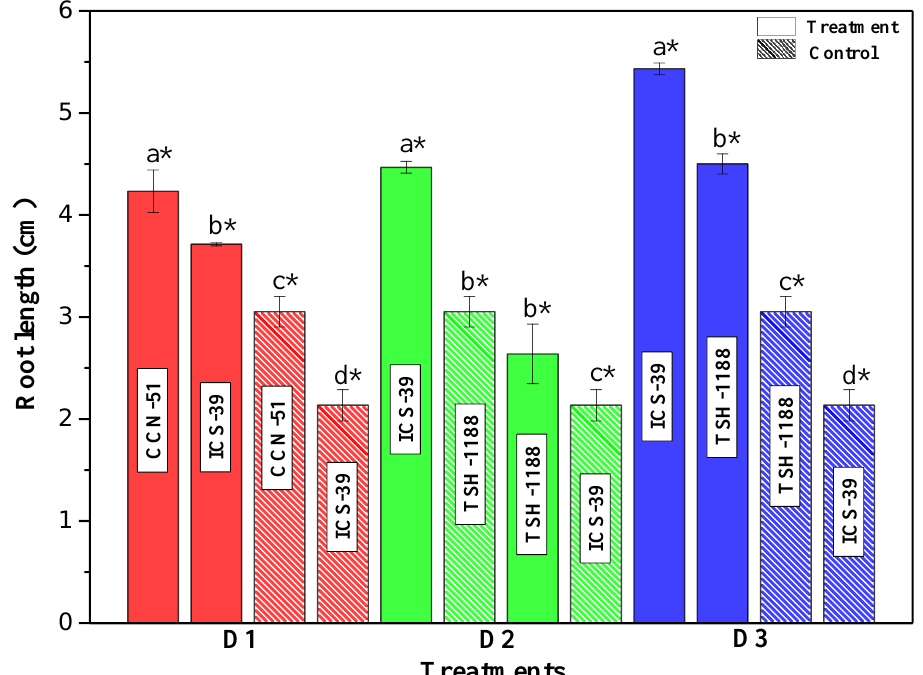
Figure 10. Average root length of seedlings subjected to zeolite 5A treatments. The histograms show the three treatments represented by three different colors, and within each treatment the length of the root denoted by the same symbol corresponding to each letter is compared. * p < 0.05. a, b, c, and d denote the groups that had statistical significance among themselves, within each treatment.